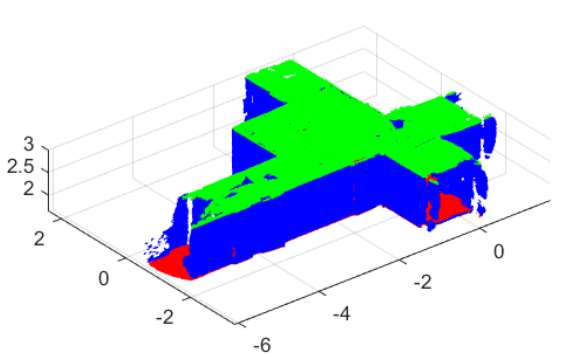
Figure 2. PC with three different surface types